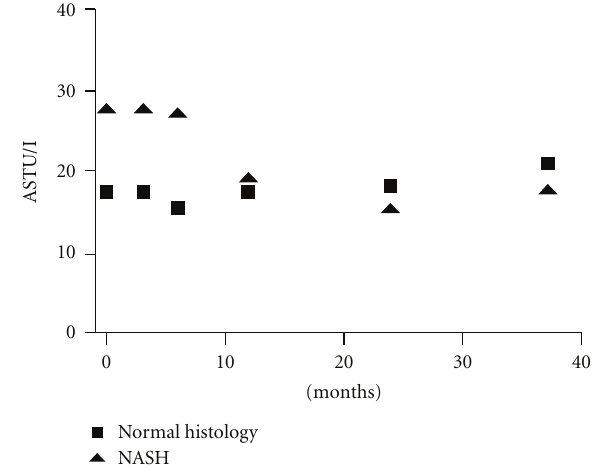
Figure 3: Course of AST levels over a 3-year followup. A significant reduction of AST levels could be shown for NASH patients (ANOVA P < .